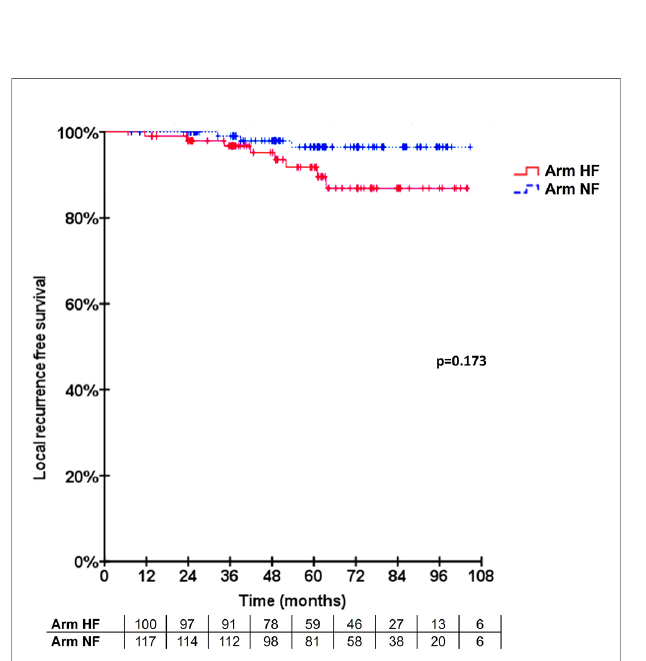
FIGURE 1 | Incidence of secondary events. The cumulative incidence of patients developing secondary events (GI-III) is displayed in a cross-sectional fashion for each treatment arm and time point.